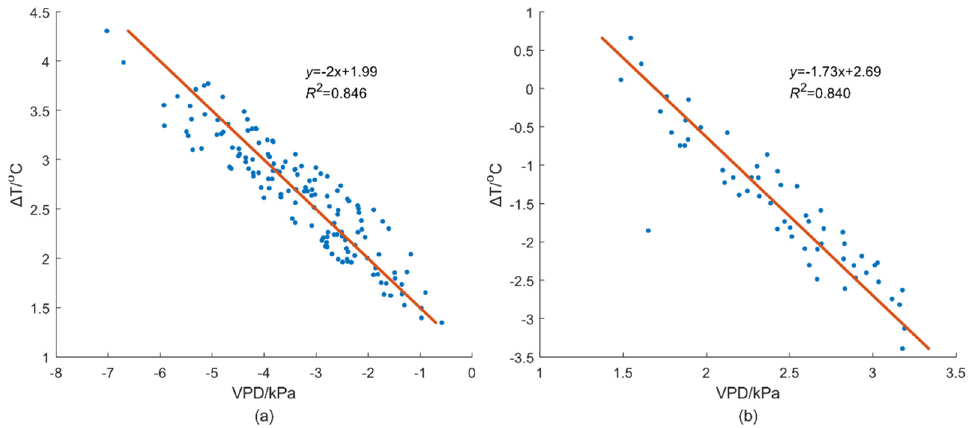
Figure 6. Linear regression fitting results for ∆ T and VPD: ( a ) fitting results in the V stage; ( b ) fitting results in the R stage.